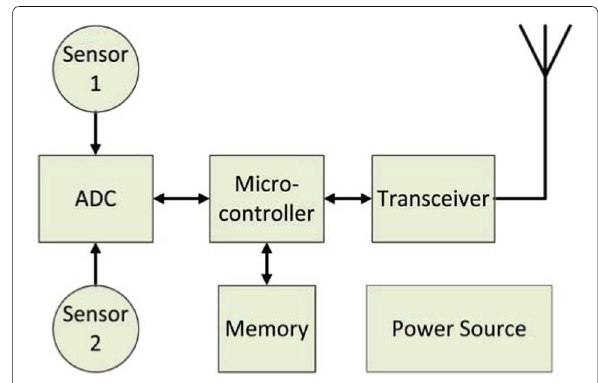
Fig. 1 Components of a sensor node